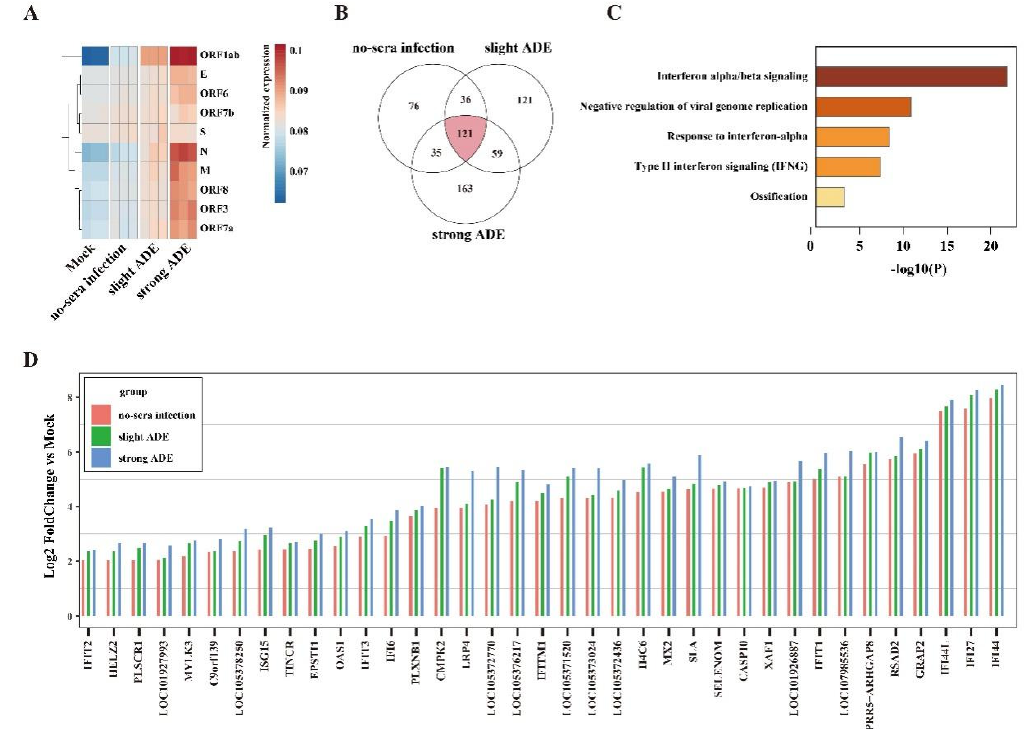
Figure 3. Antibody-dependent enhancement of excessive immune activation. Mock or SARS-CoV-2 infected Raji B cells with or without convalescent sera were harvested at 48 h post infection and subjected for RNA-seq analysis. ( A ) Heatmap showing the correlation of different groups and the viral genes that were enriched in samples compared to mock cells. ( B ) Common upregulated genes and respective upregulated genes of no-sera infection, slight ADE, and strong ADE group. ( C ) GO showing the most significant upregulated genes in ADE group cells compared to the no-sera treated infected cells. ( D ) Log2 fold change of the commonly upregulated genes in no-sera infection, slight ADE, or strong ADE groups compared to the mock infected group.